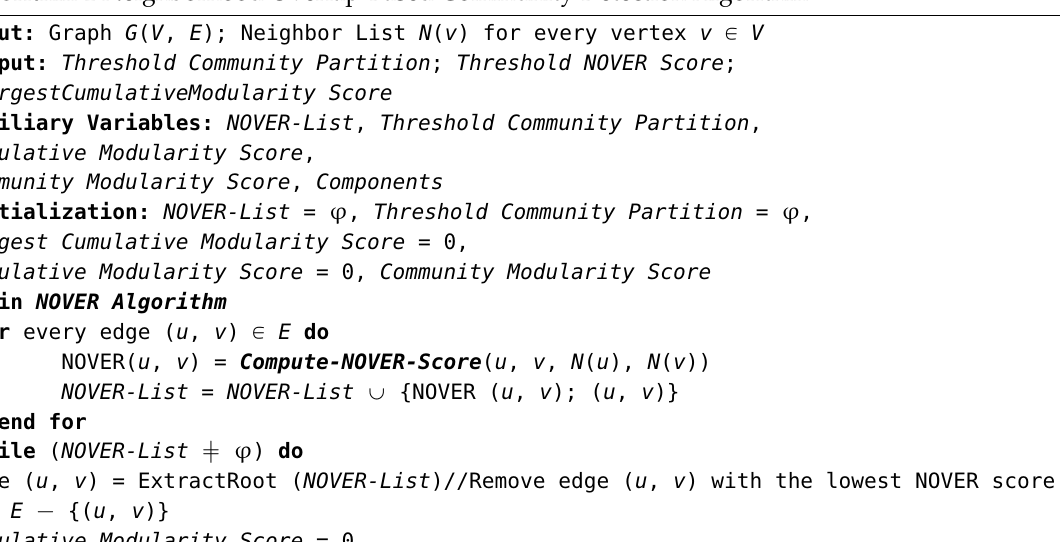
Algorithm 1 Neighborhood Overlap-Based Community Detection